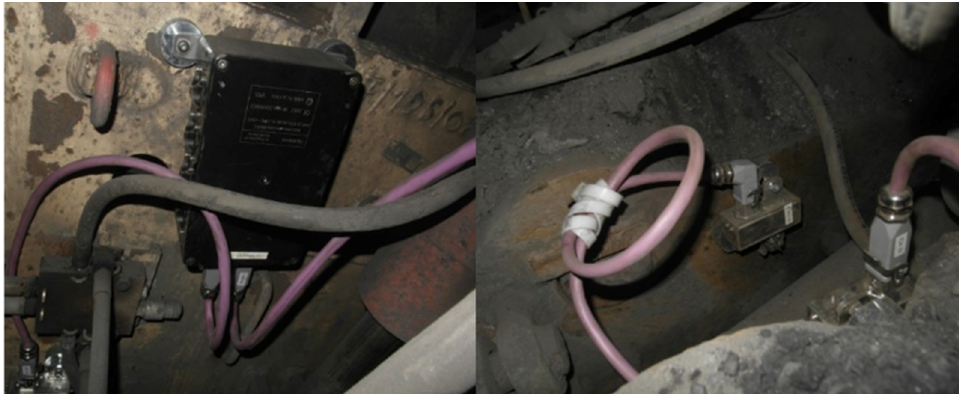
Figure 6. SSMS system components: Central unit SSMS-C and Inclinometer SSMS-I mounted on the shield support.